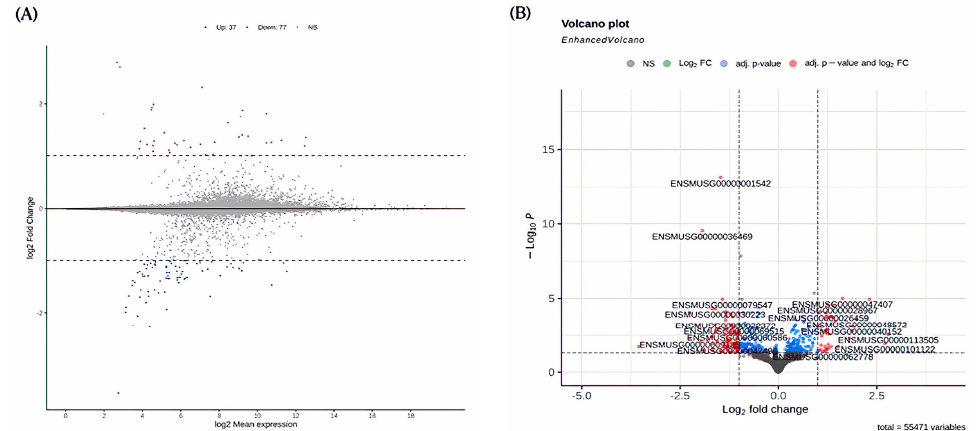
Figure 8. Different gene expression in EX + RES150 and EX groups. ( A ) MA plot illustrating the distribution of upregulated and downregulated genes (coloured dots) for EX + RES150 group vs. EX group; ( B ) volcano plot illustrating significance and fold change of the up and downregulated genes (coloured dots) for EX + RES150 group vs. EX group.